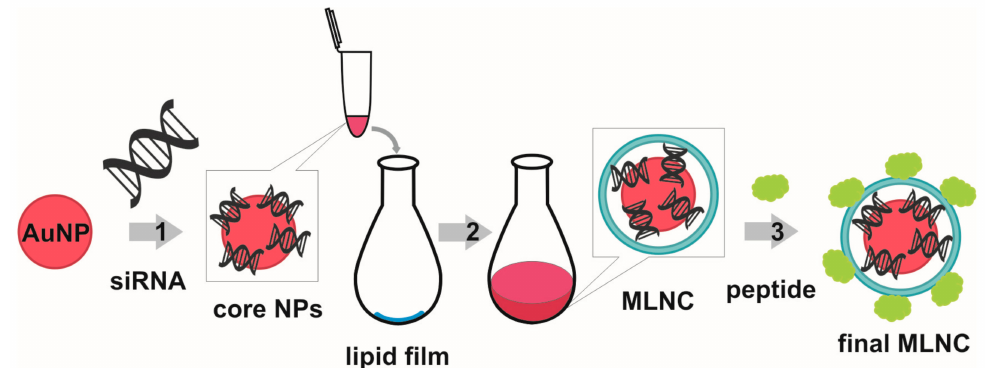
Figure 1. MLNC preparation scheme, basic stages: 1: non-covalent covering of AuNPs with siRNA (preparation of core NPs); 2: enveloping of the core NPs with pre-prepared lipid film (preparation of MLNC); 3: doping of lipid envelope with cell penetrating peptide (preparation of final MLNC). Adapted from